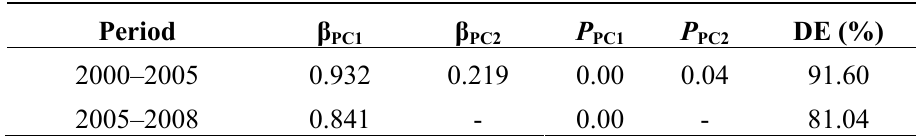
Table 7. Results by performed